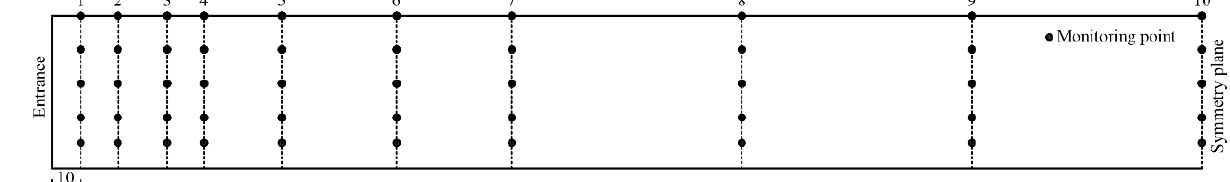
Figure 7. Aerodynamic pressure time histories obtained by coarse mesh and fine mesh.